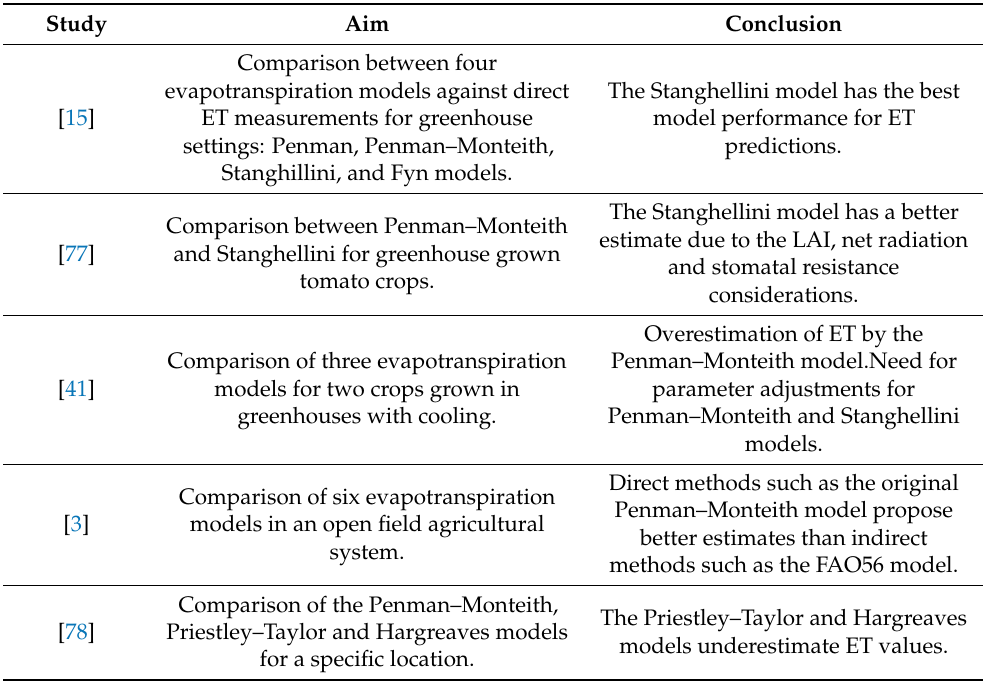
Table 3. Studies comparing evapotranspiration